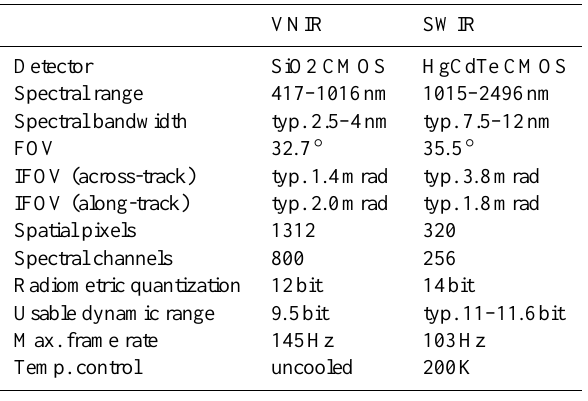
Table 1. Properties of the two SPECIM imaging spectrometers em- ployed in specMACS for so-called visible, near-infrared, and short- wave infrared spectral ranges as characterized in this work. Here, FOV means the field of view of the complete spatial line, while IFOV denotes the instantaneous field of view of single pixels, which determines the spatial resolution along- and across-track.